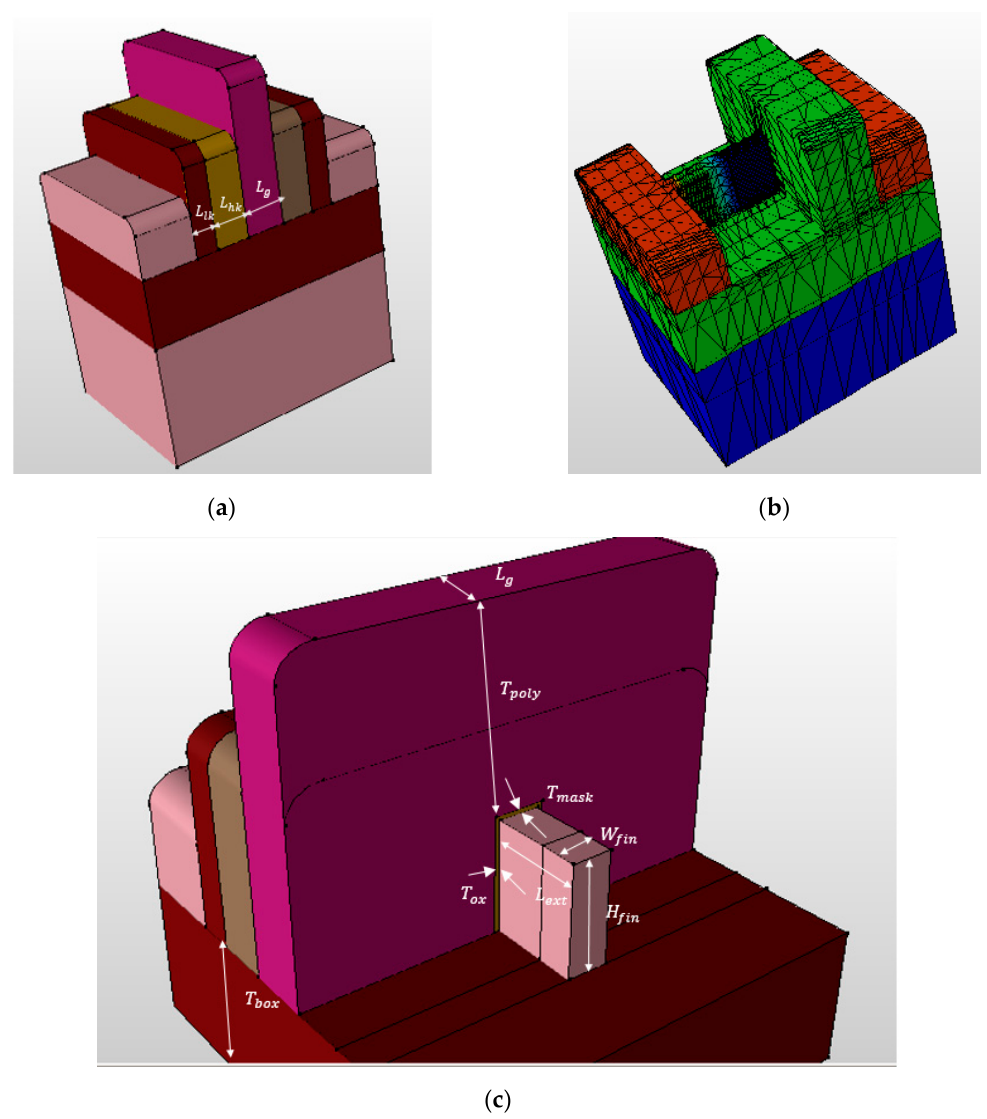
Figure 1. Schematic diagrams of AsymD-kk FinFE: ( a ) 3D view; ( b ) channel profile of FinFET source side; ( c ) cross section.